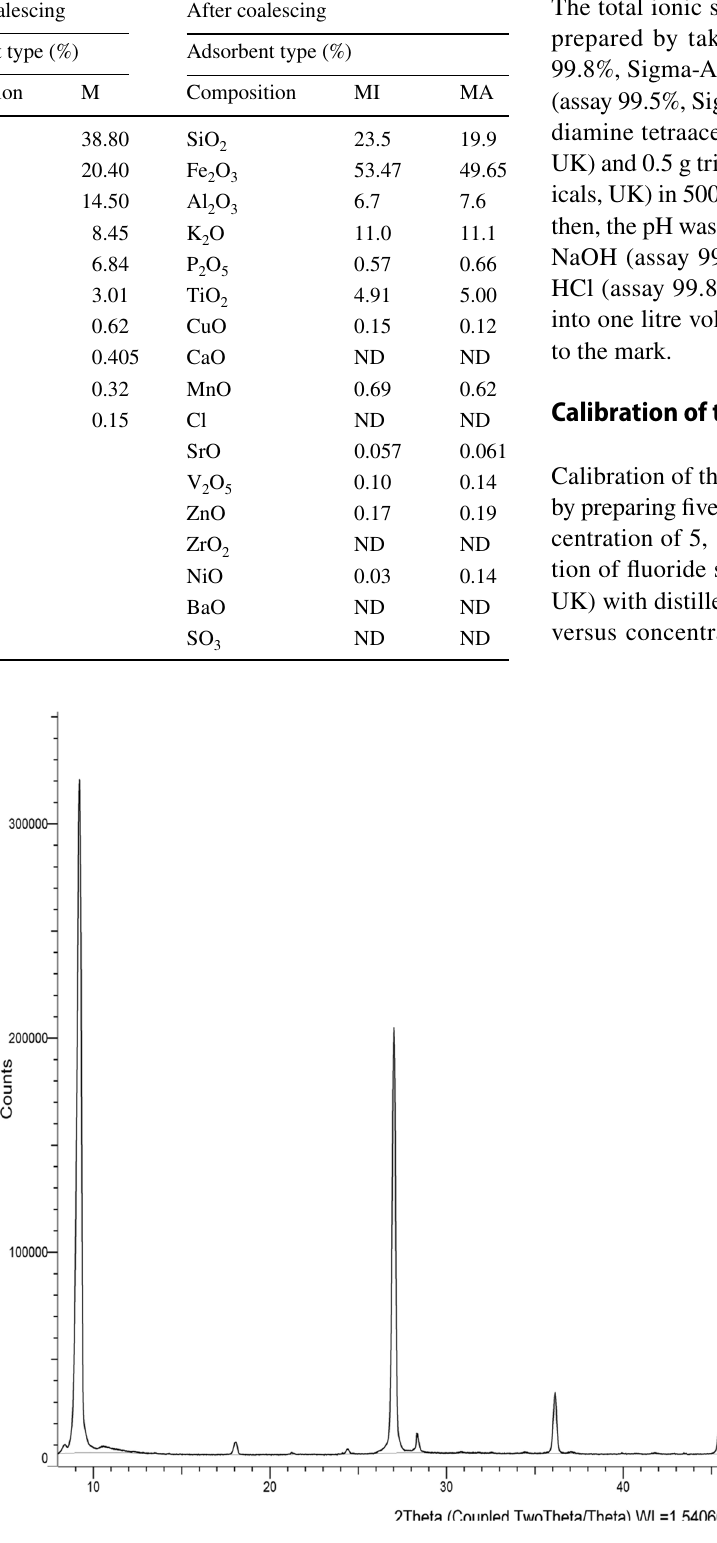
Fig. 2 X-ray diffractogram of